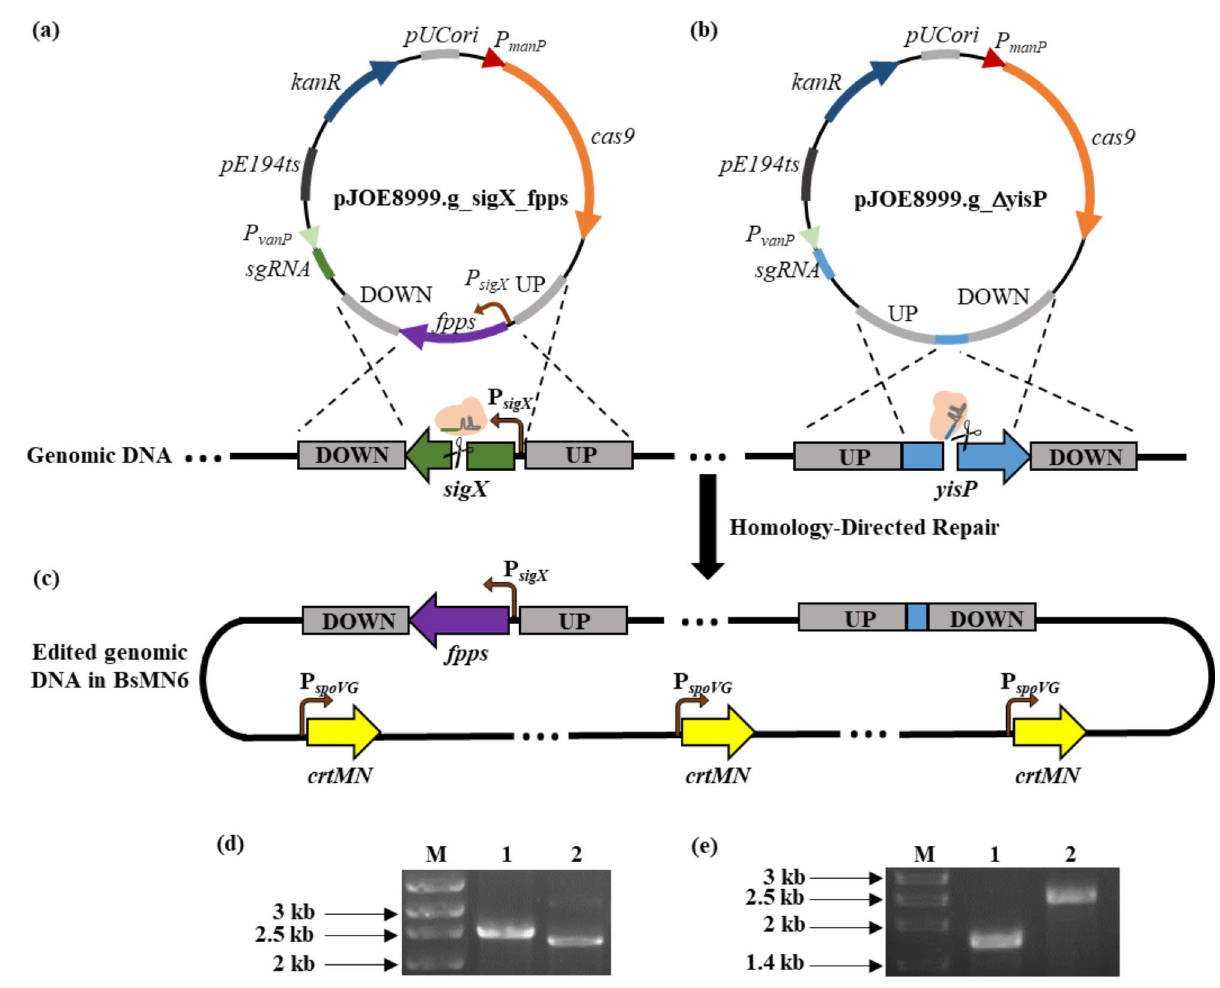
Fig. 3 Engineering of the genome-integrated farnesyl diphosphate synthase (FPPS) and disruption of farnesyl diphosphate phosphatase (YisP) in B. subtilis . ( a ) pJOE8999.g_sigX_fpps was designed to allow the replacement of the sigX gene from B. subtilis by the fpps gene from B. megaterium under the control of a strong promoter P sigX . ( b ) pJOE8999.g_ΔyisP was constructed for the disruption of the yisP gene from B. subtilis ( c ) Upon transformation, the resulting B. subtilis strain harboring both genomic modifications along with three gene-copies of the crtMN genes under the control of the constitutive promoter P sigX was designated as BsMN6. ( d ) Confirmation of the sigX gene replacement by fpps in the BsMN5 strain. Lane 1 corresponds to an ampli- fication band of 2.5 kb using primers P2F/P4R to verify fpps integration at the sigX locus site in BsMN5. Lane 2 corresponds to an amplification band of 2.25 kb using the same primers in recipient strain BsMN3. M corresponds to the molecular marker weight. ( e ) Confirmation of the yisP gene disruption in strain BsMN6. Lane 1 corresponds to an amplification band of 1.75 kb using primers P5F/P6R to verify yisP deletion in BsMN6. Lane 2 corresponds to an amplification band of 2.5 kb using the same primers in recipient strain BsMN5. M corresponds to the molecular marker